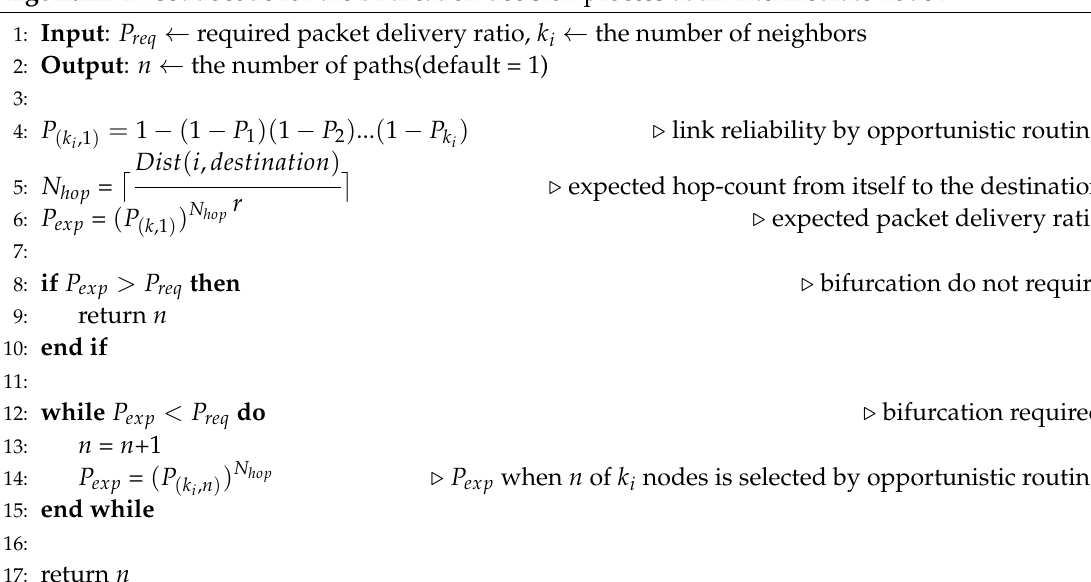
Algorithm 1 Pseudocode for the bifurcation decision process at an intermediate node